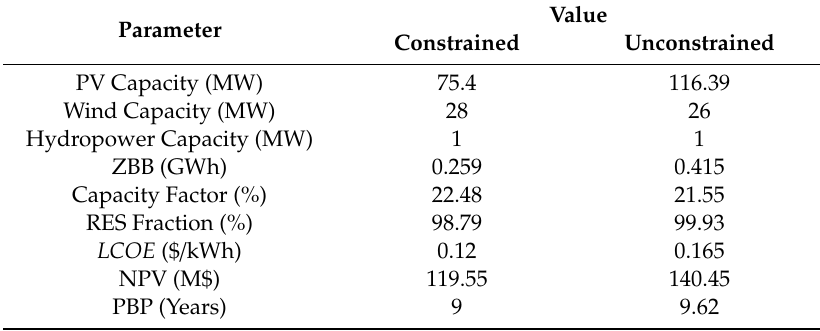
Figure 7. Demand met by the RES components with ESS (LCOE of 0.165 $ / kWh). Table 4. Technical and economic performance parameters of the PV / wind-hydro system with